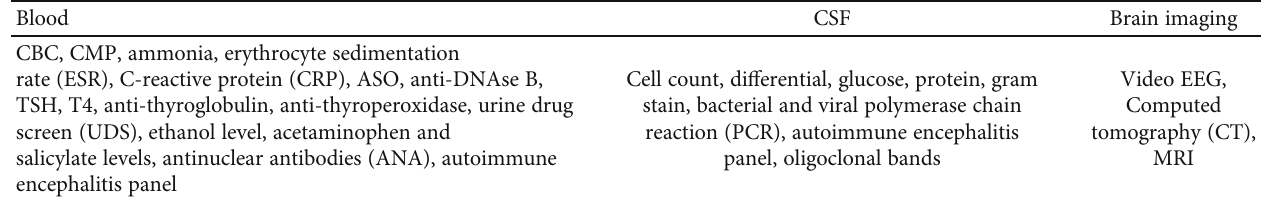
Table 2: List of suggested investigations for